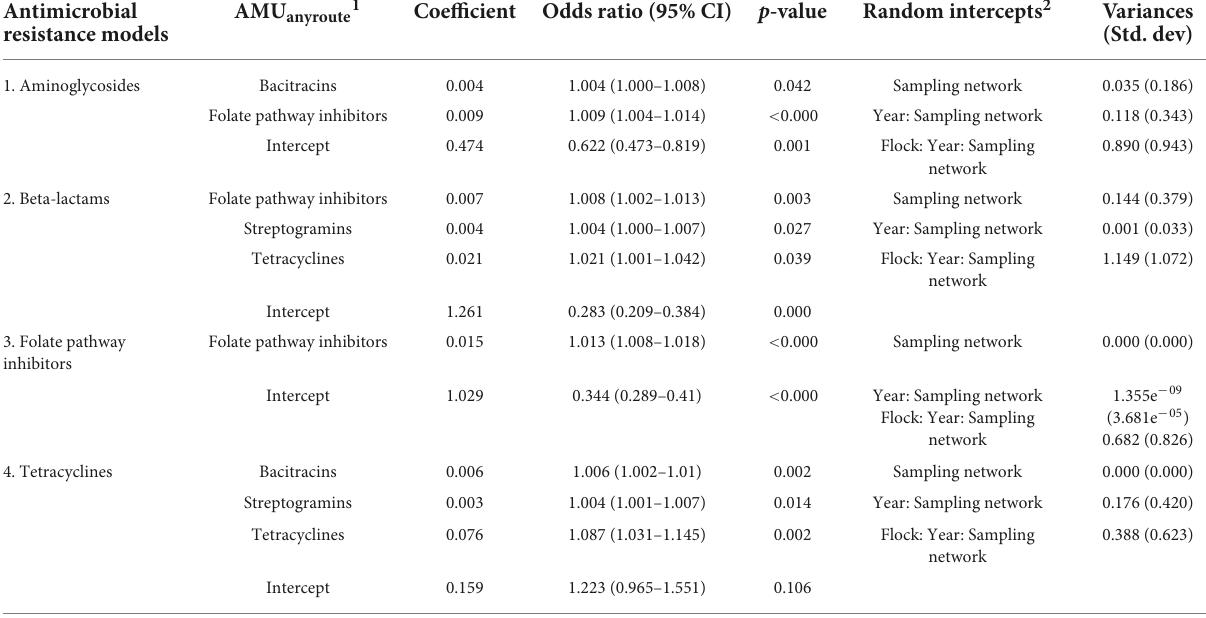
TABLE 2a Multivariable mixed-effects logistic regression models showing associations between antimicrobial use via any route of administration in turkey flocks ( n = 334) and homologous and multiclass resistance in E. coli isolates ( n = 1,317), 2016–2019. Antimicrobial resistance